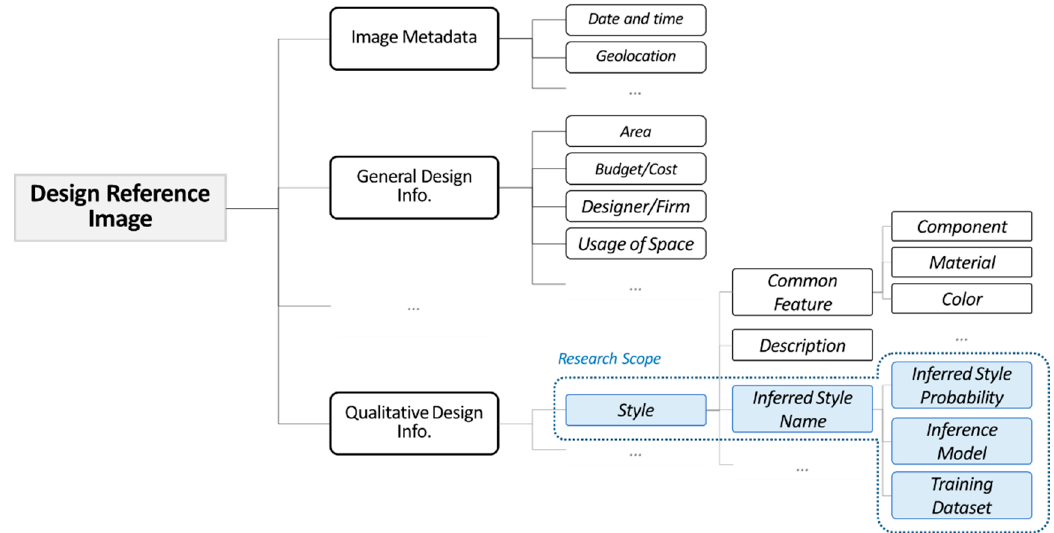
Figure 2. Conceptual data structure of design reference and style data scheme.